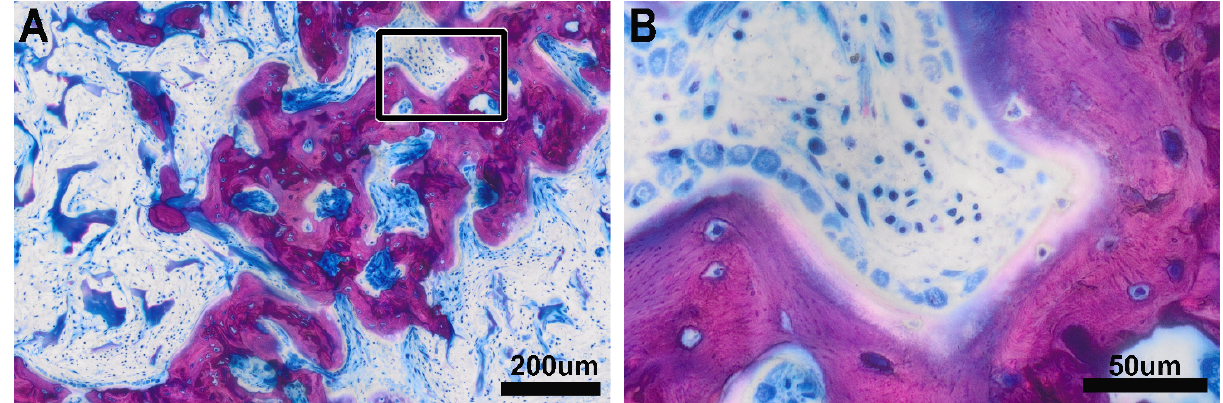
Figure 4. New bone in the defect area. Typical morphology of the newly formed bone with the different shades of dark pink staining of a bone that forms within the VSCM ( A ). The ultimate hallmarks of bone are the osteoblastic seams separated by the osteoid layer from the mineralization zone ( B ). The osteocytes are embedded in the newly formed osteoid layer. The morphological appearance of the newly formed bone is in sharp contrast to the areas considered as mineralized chondrogenic cells.